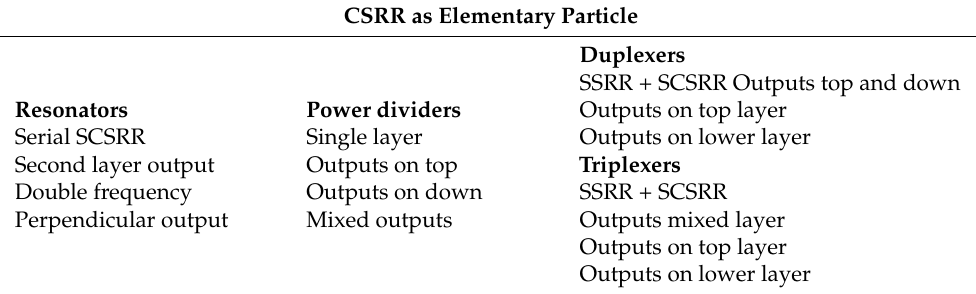
Table 1. Schema of the structure of this